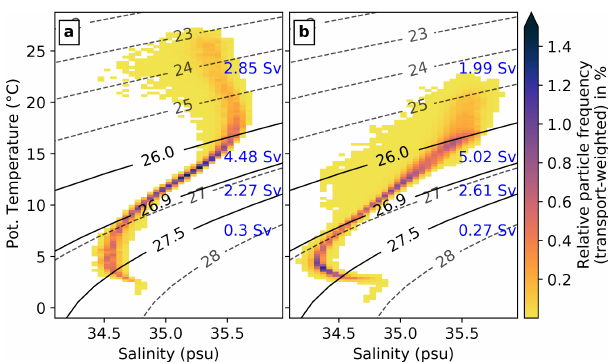
Figure 5. θS diagram of Agulhas leakage for experiment P (a) in the Agulhas Current at 32 ◦ S and (b) at the first crossing of the Good Hope section. The relative transport-weighted particle frequency is shown per 0.25 ◦ C × 0.05 psu bin in percent. Potential density lev- els used to separate upper, central, intermediate and deep waters are highlighted by solid black lines, and blue numbers indicate the transport of these water